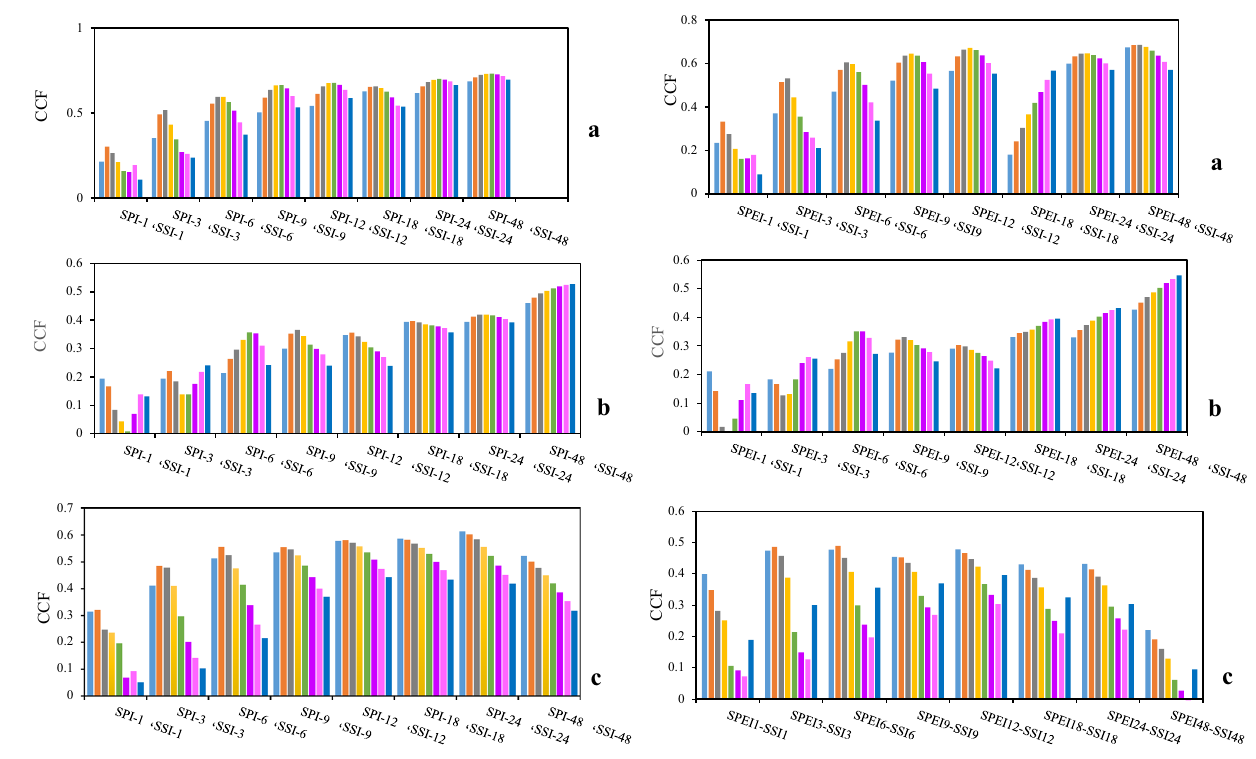
Fig. 4 Crossover correlation between indices simultaneously in the a Navroud, b Lighvan, c